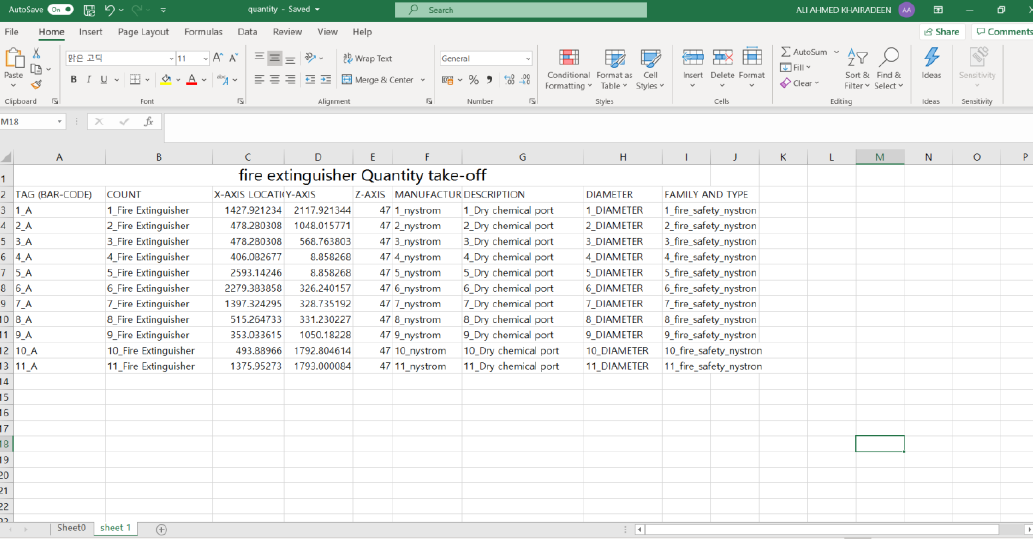
Figure 9. Bill of quantities (BoQs) for portable firefighting Equipment